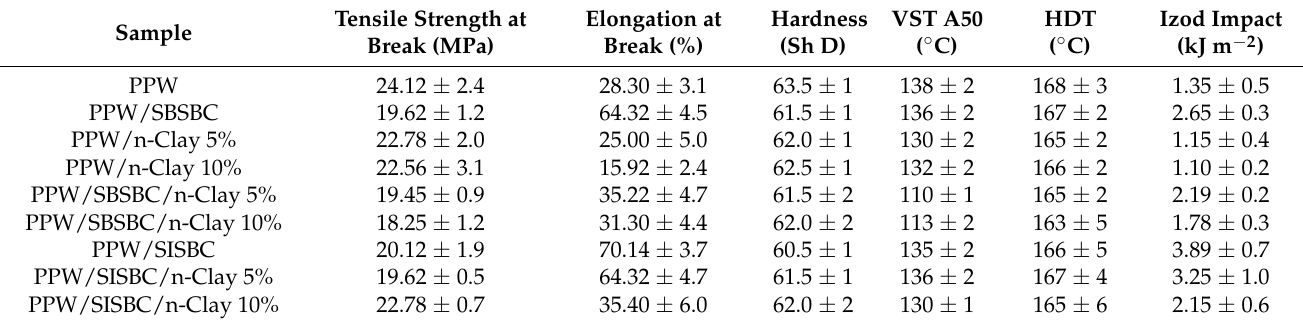
Table 7. Mechanical characteristics for PPW/SBSBC, PPW/SISBC, PPW/SBSBC/n-Clay, and PPW/SISBC/n-Clay composites compared with those for PPW and